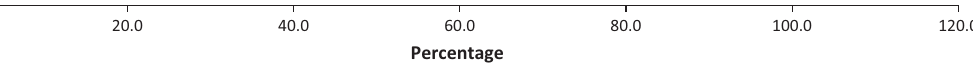
FIGURE 3: Ivory Park, percentage of enterprise category situated on the high